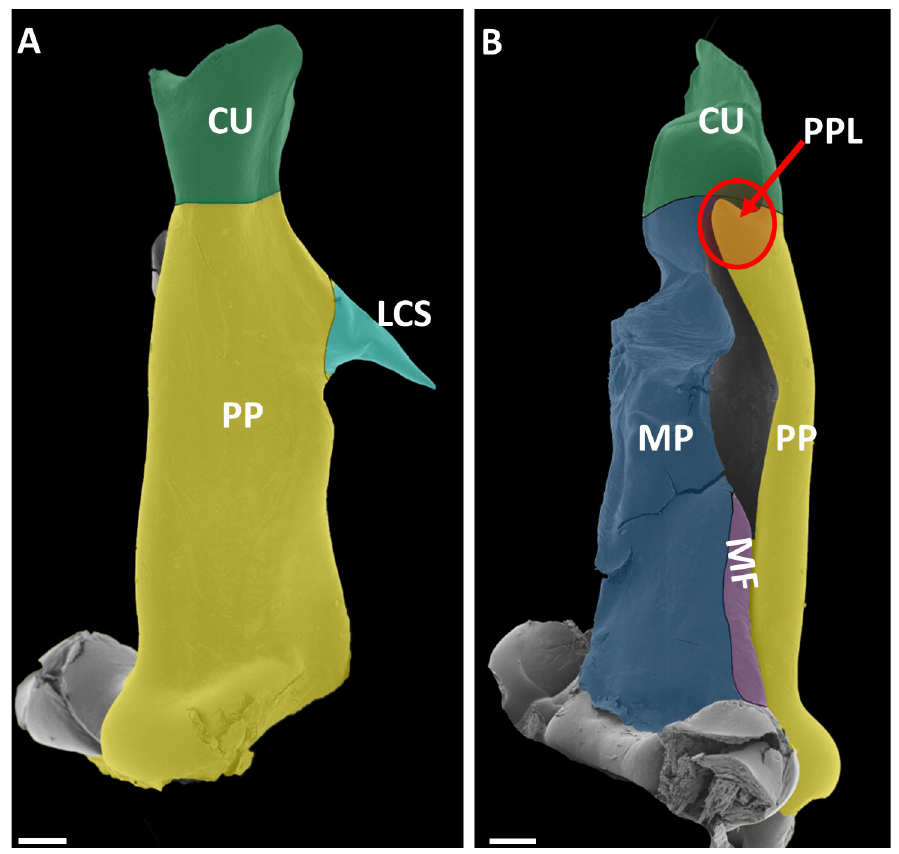
Fig. 5. Odontopygid gonopod terminology, coxa, exemplified by Chaleponcus sergeii sp. nov., holotype, ♂ (NHMD 621728). A . Right gonopod coxa, anterior view. B . Right gonopod coxa, mesal view. Abbreviations and shading: CU = cucullus (green); LCS = lateral coxal spine (teal); MP = metaplica (blue); MPF = metaplical flange (purple; not very large in this specimen); PP = proplica (yellow); PPL = proplical lobe (orange; red circle). Scale bars: A–C = 0.2 mm; D = 0.01 mm. Cf. Fig.